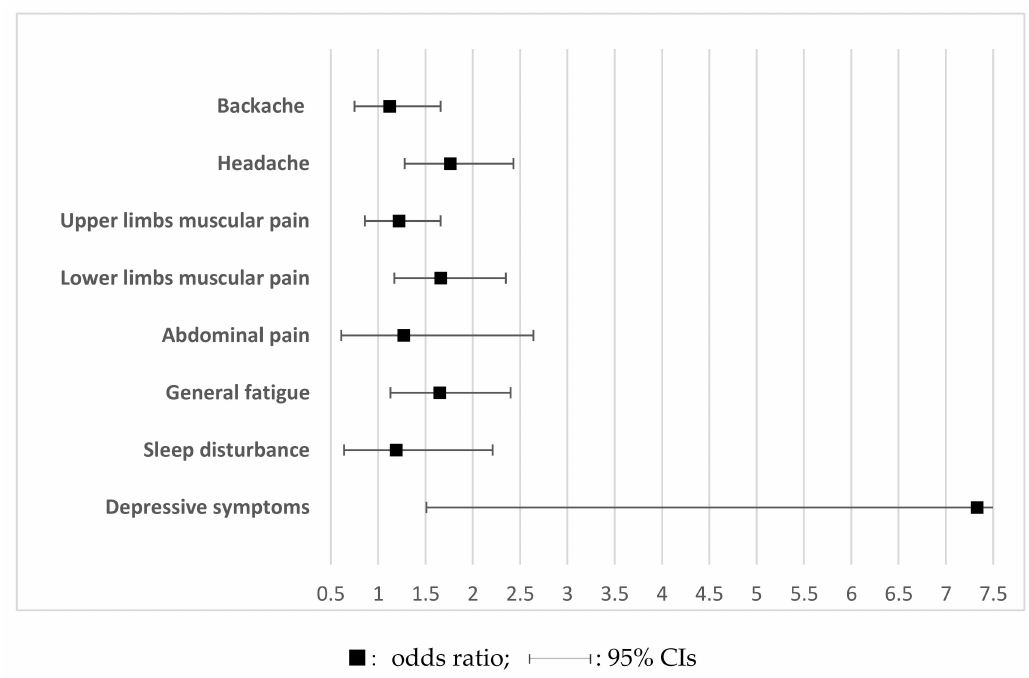
Figure 2. Associations between the emotional expression guide (reference: Yes) and work-related health problems in the univariate logistic